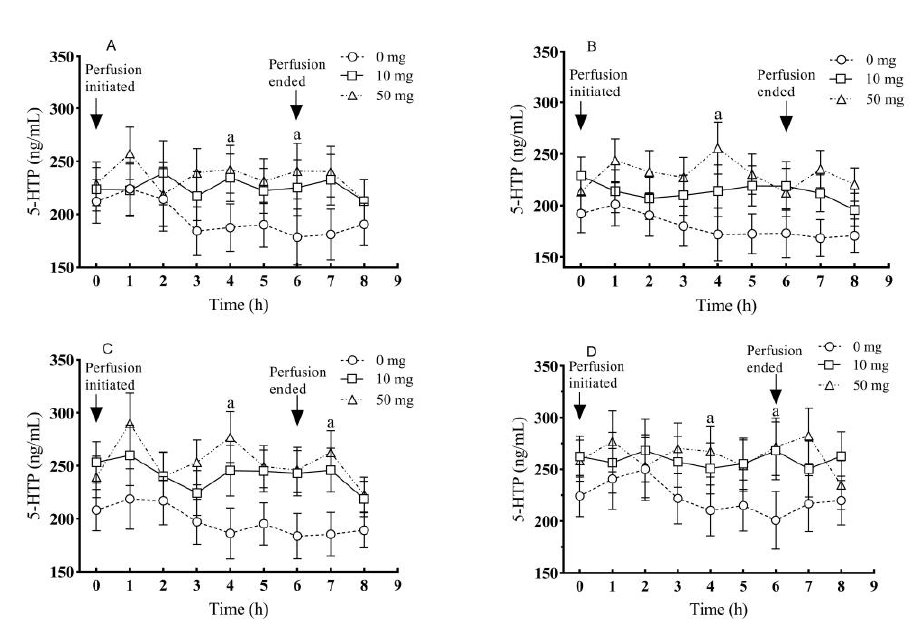
Figure 5. Effects of different levels of duodenal 5-HTP perfusion on the timely dynamic changes of blood 5-HTP in different blood vessels: ( A ) portal vein, ( B ) carotid artery, ( C ) jugular vein and ( D ) posterior vena cava. The data were expressed as LSM ± SEM ( n = 6). Small letters indicate p < 0.05 vs. their respective controls.